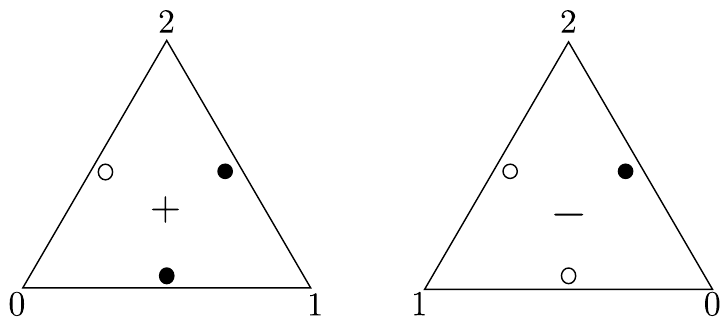
Figure 1 . Assignment of Grassmann variables on 1-simplices. (cid:18) (resp. (cid:18) ) is represented as a black (resp. white)